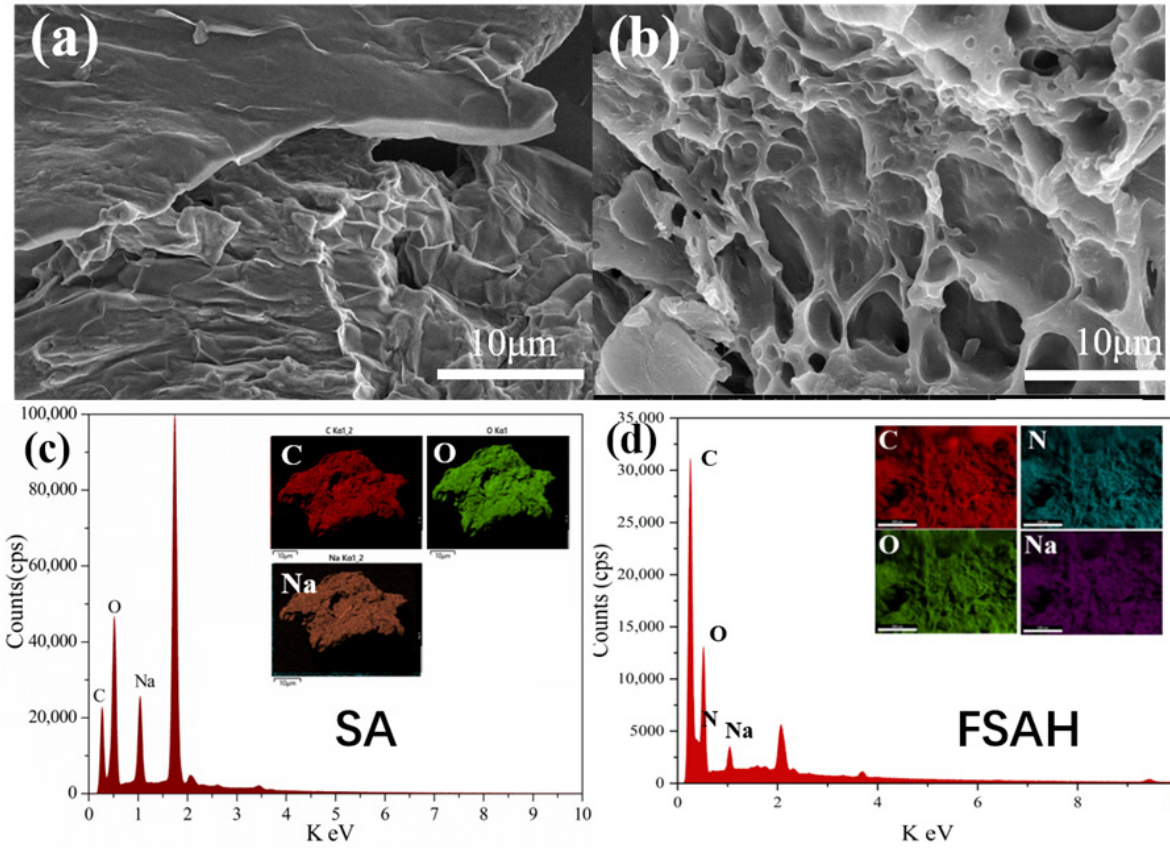
Figure 1. SEM of SA ( a ) and FSAH ( b ); EDS ‒ mapping of SA( c ), FSAH ( d ).